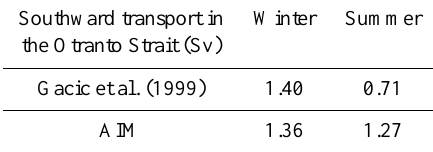
Table 4. Estimates of the southward transport (Sv) in the Otranto Channel from Gacic et al. (1999) and from the AIM simulation Southward transport in Winter Summer the Otranto Strait (Sv) Gacic et al. (1999) 1.40 0.71 AIM 1.36 1.27